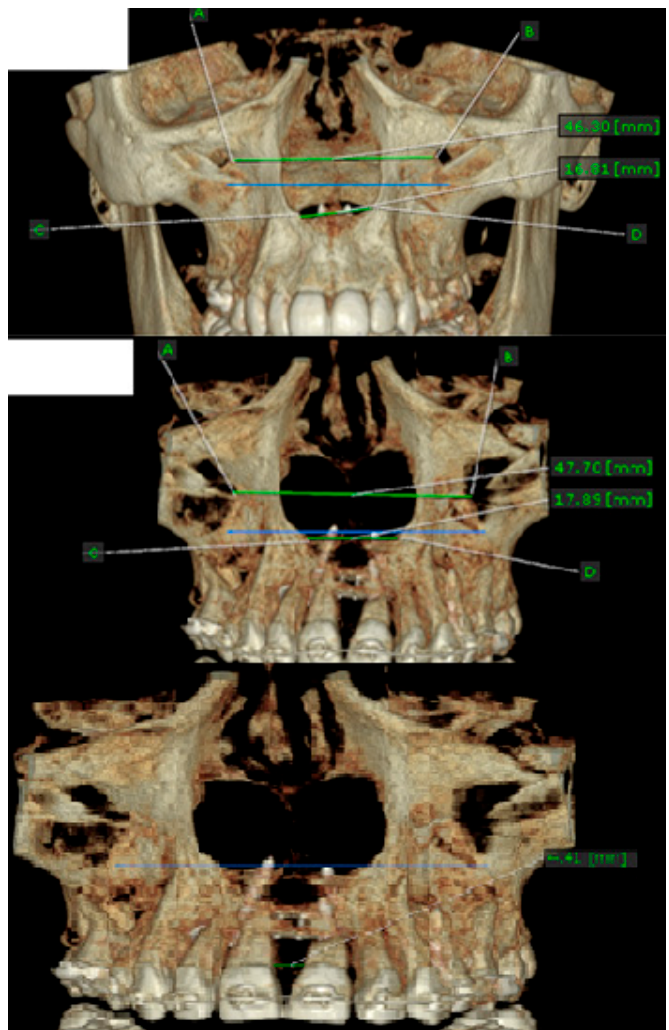
Figure 10. Cone Beam Computed Tomography CBCT images used in the study showing different measurements before and after the treatment: A: most mesial point of the infraorbital foramen right side; B: most mesial point of the infraorbital foramen left side; C: most lateral point of the nasal notch right side; D: most lateral point of the nasal notch left side.